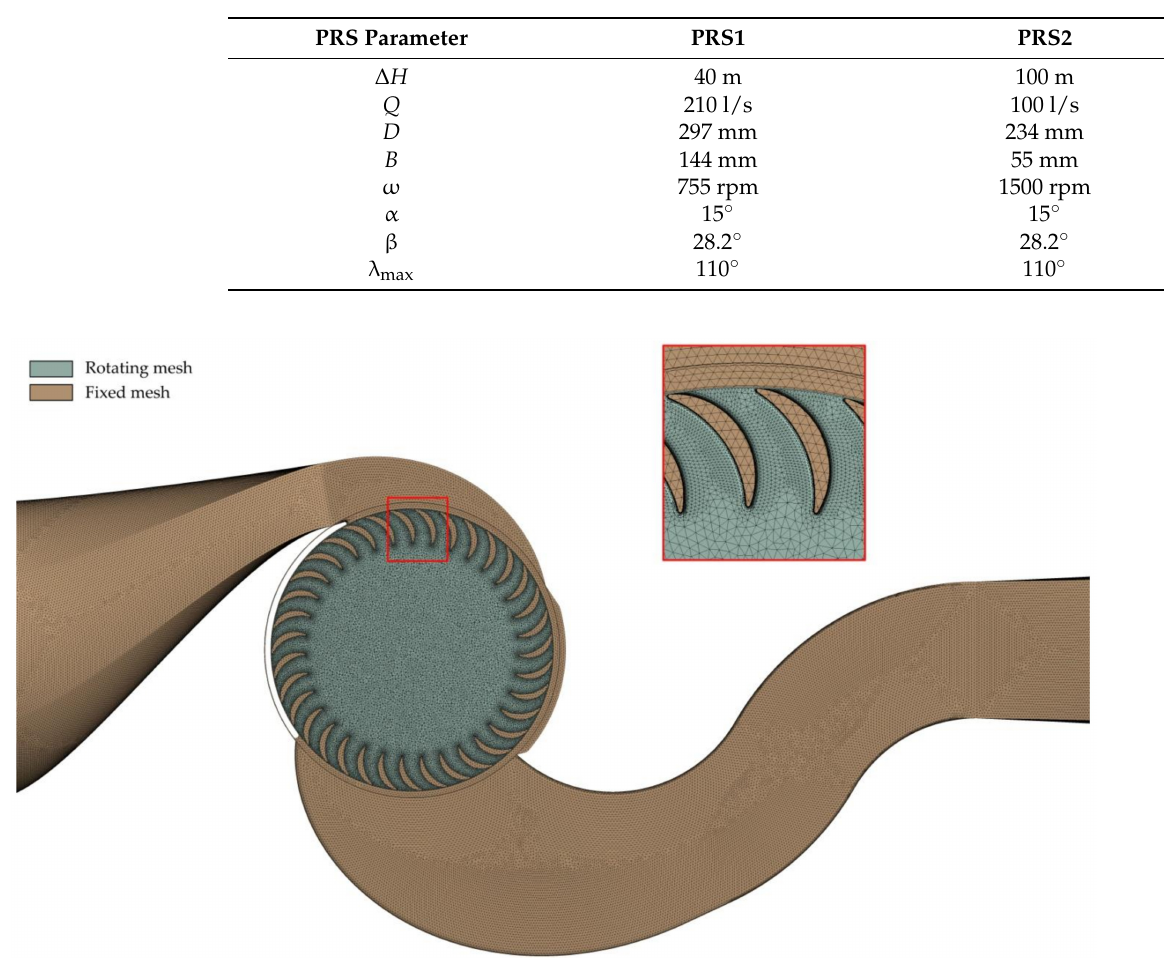
Table 1. PRS1 and PRS2 parameters.